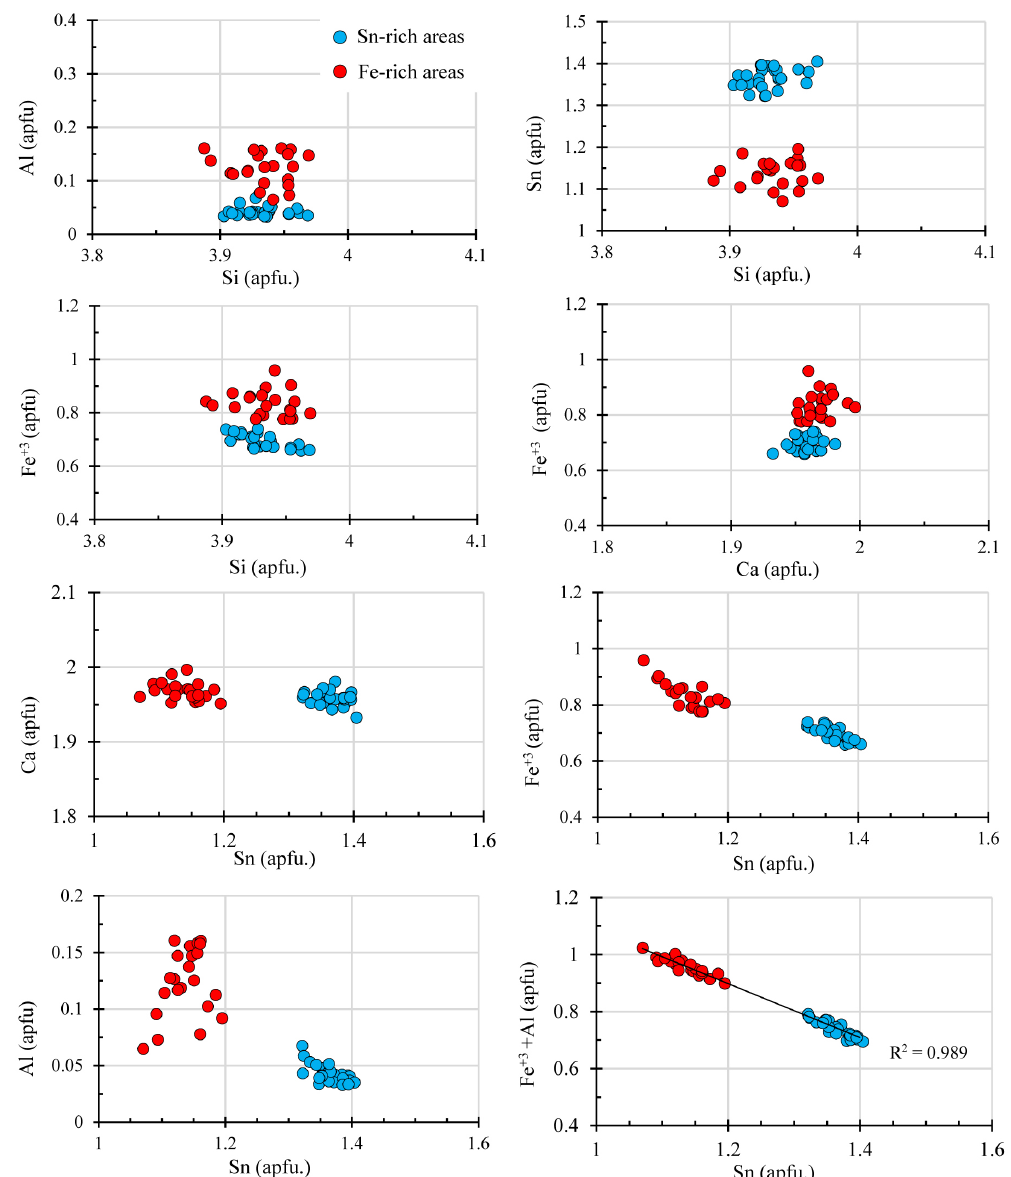
Figure 3. Binary diagrams showing the correlation between elements (in atoms per formula unit, apfu) from silesiaite electron microprobe